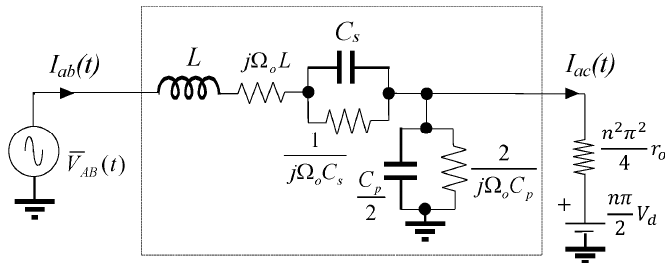
Figure 5. Large-signal envelope model of the inverter stage.